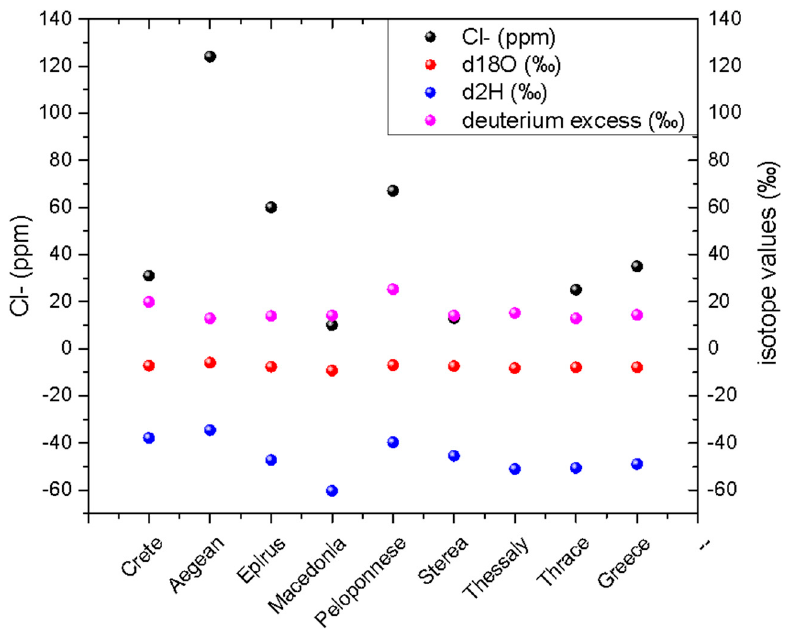
Figure 2. Average δ 18 O, δ 2 H, deuterium excess (d), and Cl − values for each region and for Greece.